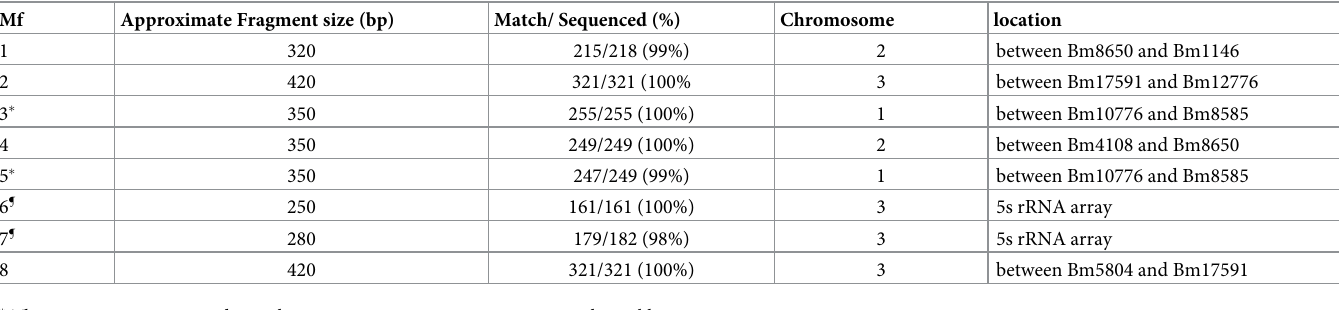
Table 3. Location of piggyBac insertions in genomes of individual